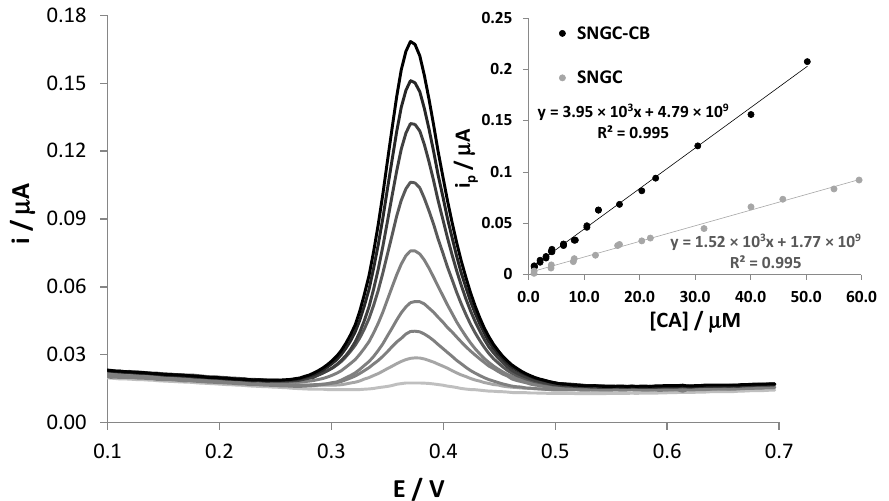
Figure 2. DPV signals of SNGC-CB electrode in 0.1 M AB pH = 4.0 solution in the presence of different concentrations of CA. Inset: calibration curves obtained with SNGC and SNGC-CB electrodes.